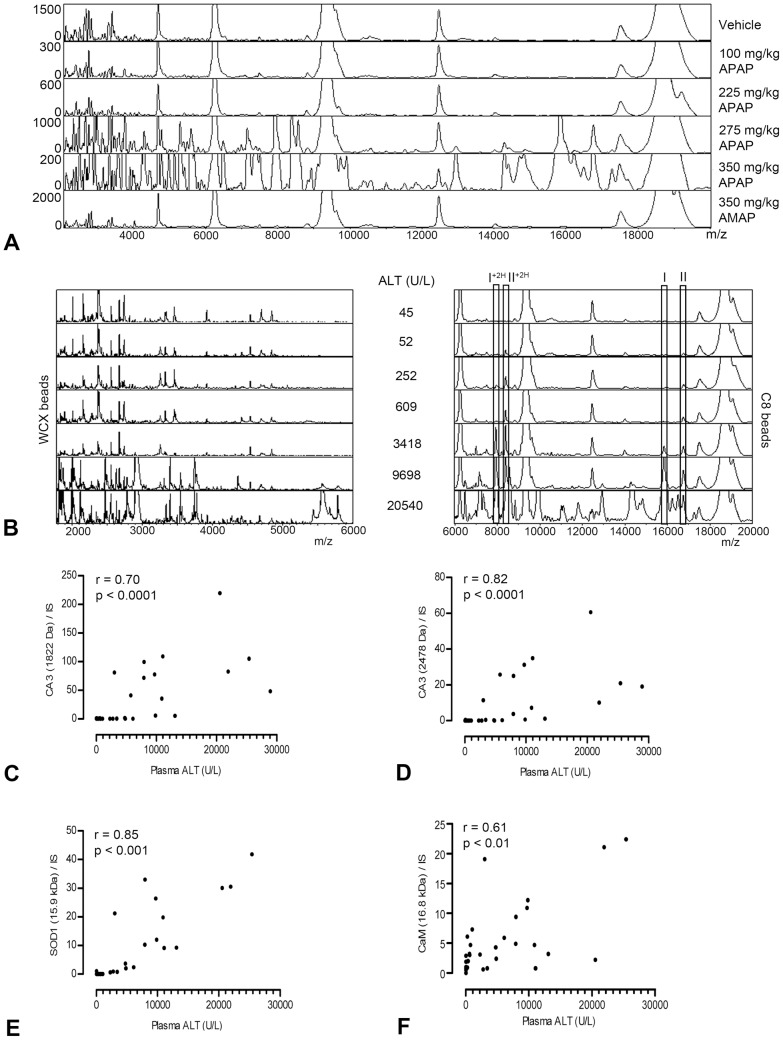
Urinary protein profiles of APAP-induced liver injury in mice.Representative urine protein profiles of m/z values versus peak intensity illustrate an APAP dose-related increase in urinary protein excretion (A). ALT-dependent increases in protein peaks were observed in urine samples pretreated with WCX beads or C8 beads (B). The protein masses of 15.9 kDa and 16.8 kDa are indicated by (I) and (II), respectively. Double charged forms are indicated by (+2H). The correlation between the relative peak intensity of two representative urinary CA3 fragments (C & D), SOD1 (E), and CaM (F) and plasma ALT was determined using the Spearman's rank correlation coefficient (r) in mice with APAP dose ≥275 mg/kg body weight. ALT: alanine aminotransferase; APAP: acetaminophen; CA3: carbonic anhydrase 3; CaM: calmodulin; SOD1: superoxide dismutase 1; WCX: weak cation exchange.